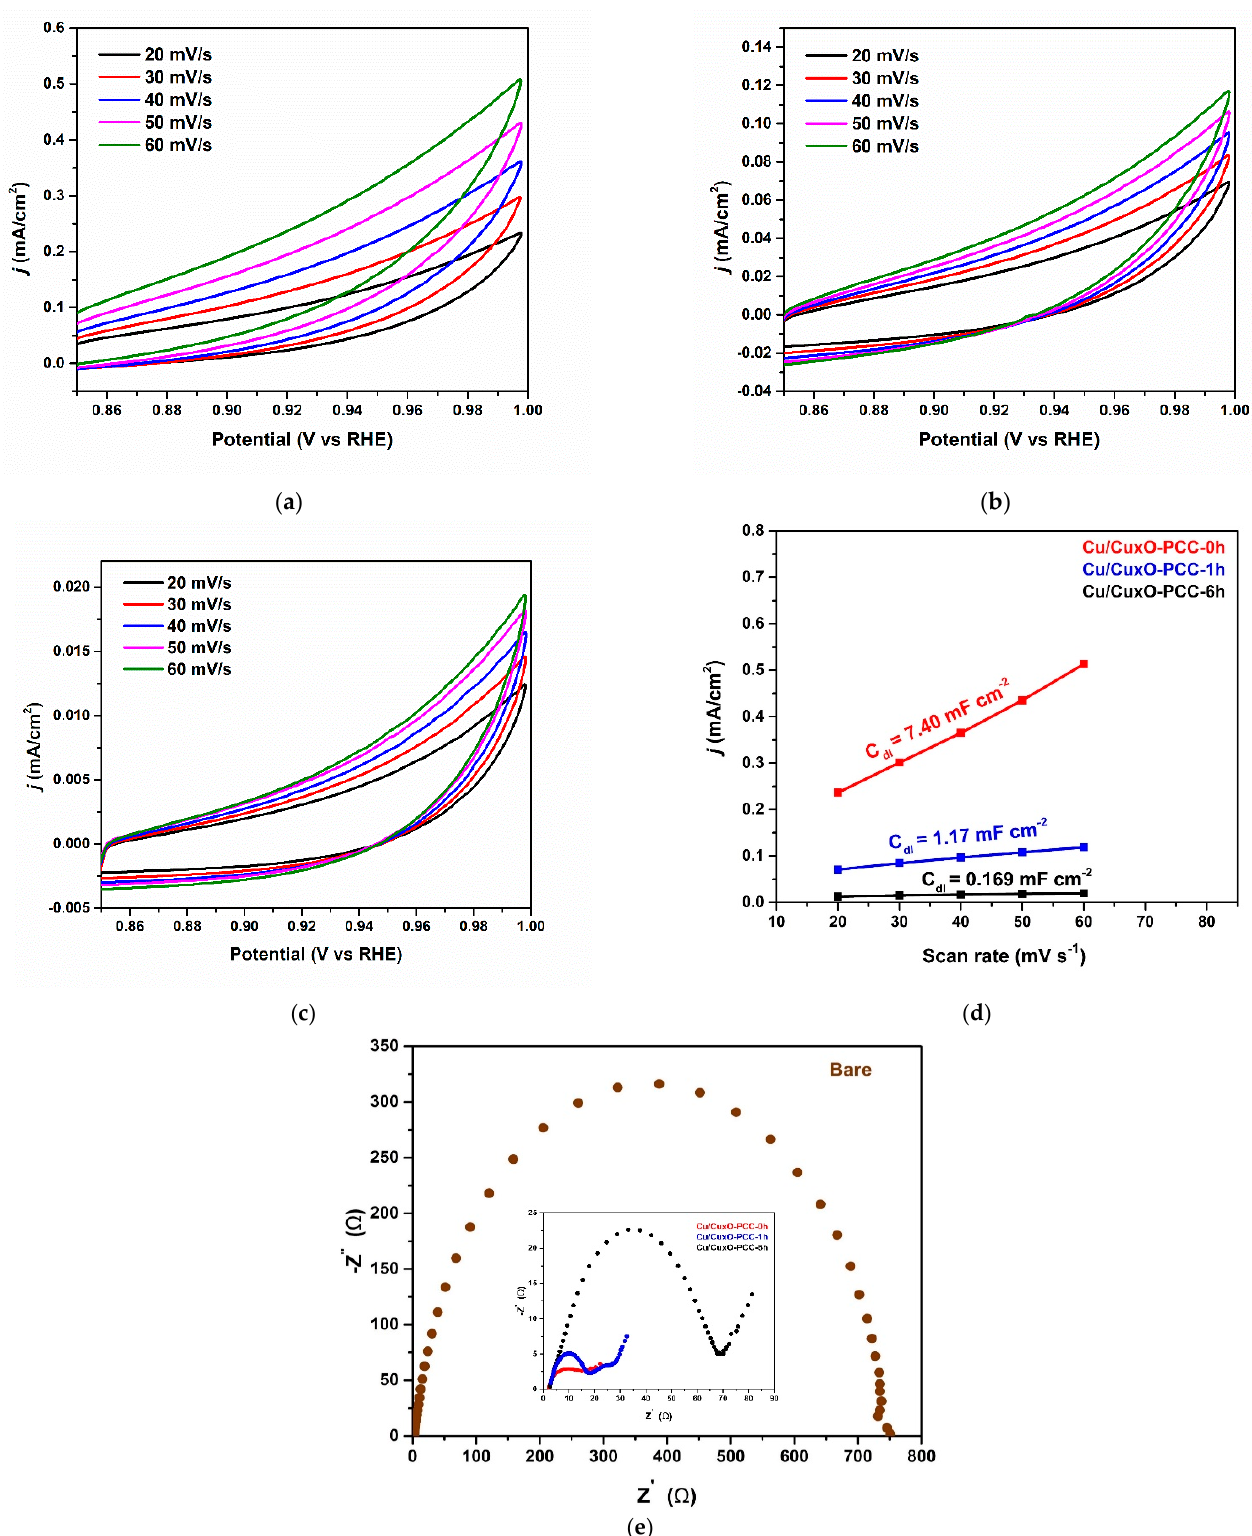
Figure 10. ( a – c ) CV plots electrochemical double-layer measurement electrolytes for Cu/Cu x O-PCC-0h, Cu/Cu x O-PCC-1h, and Cu/Cu x O-PCC-6h, respectively. ( d ) Electrochemical double layer plot ( e ) Nyquist plots at − 0.5 V vs. RHE. Although the BET surface area of the Cu/Cu x O-PCC-0h is relatively lower than the partially leached catalysts, it displays higher double-layer capacitance and, therefore, more electrochemically active surface area. The higher BET surface area of the partially leached samples arises from leaching the Cu/Cu x O nanoparticles and the creation of more vacancies in the heterogeneous system, but this area is not electrochemically active or ac- cessible towards electrochemical reactions as for their higher charge transfer resistance. This was supported by the decrease in the current density at all potentials upon leaching. For instance, the current density at − 0.5 V vs. RHE decreased by 36% and 47% upon leach- ing for 1 and 6 h, respectively (see Table S1). Indeed, more control experiments are needed to elucidate the effect of porosity as, here, porosity is created at the expense of CO 2 reduc- tion active sites. However, it is worth mentioning that the distribution of pores on the Cu/Cu x O-PCC-0h tends to be more mesoporous in nature than the partially leached cata- lysts, which are mainly microporous and affect the functionality of nitrogen species. N- doped mesoporous carbon materials in previous reports proved to promote CO 2 conver- sion to ethanol [61]. Moreover, larger pore sizes and pore volumes are shown to enhance nitrogen functionalization by which efficient adsorption of CO 2 can be achieved [62]. As such, higher electron transfer resistance observed in the leached samples could be at- tributed to the less effective functionalization of nitrogen. The significant effect of